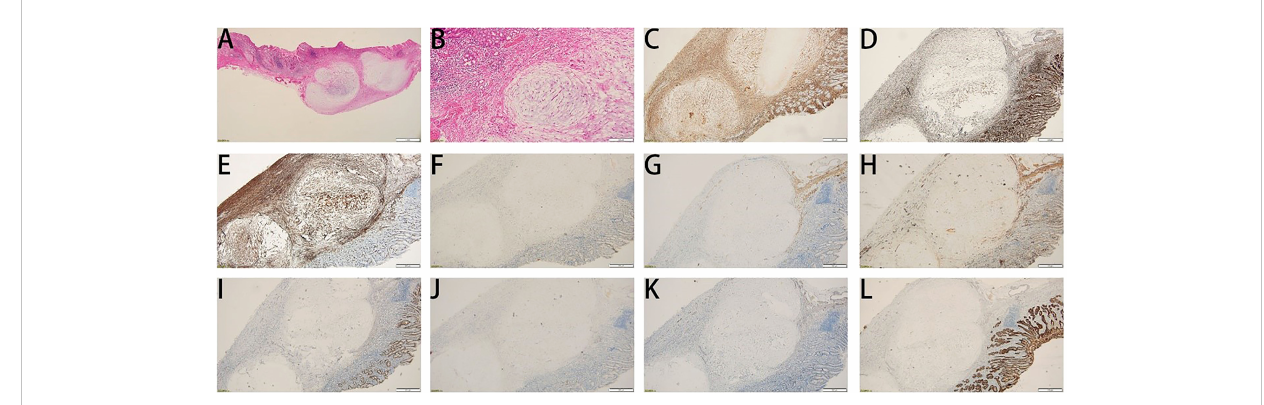
FIGURE 2 Histological features of the tumor. (A, B) Hematoxylin and eosin staining. (A) Magni fi cation: 10 ×; (B) Magni fi cation: 40 ×. (C-L) Immunohistochemical staining for vimentin (C) , SDHB (D) , CD34 (E) , CD117 (F) , DEMSIN (G) , SMA (H) , DOG1 (I) , ALK (J) , S100 (K) , and CK (L) .